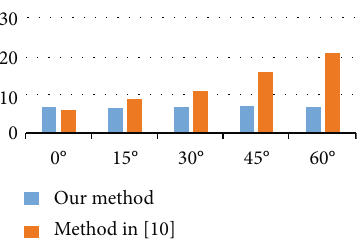
Figure 8: The performance comparison of pose estimation between the method in [10] and our method on the object with a changed structure. The accuracy is measured by the median error of di ff erent views for each